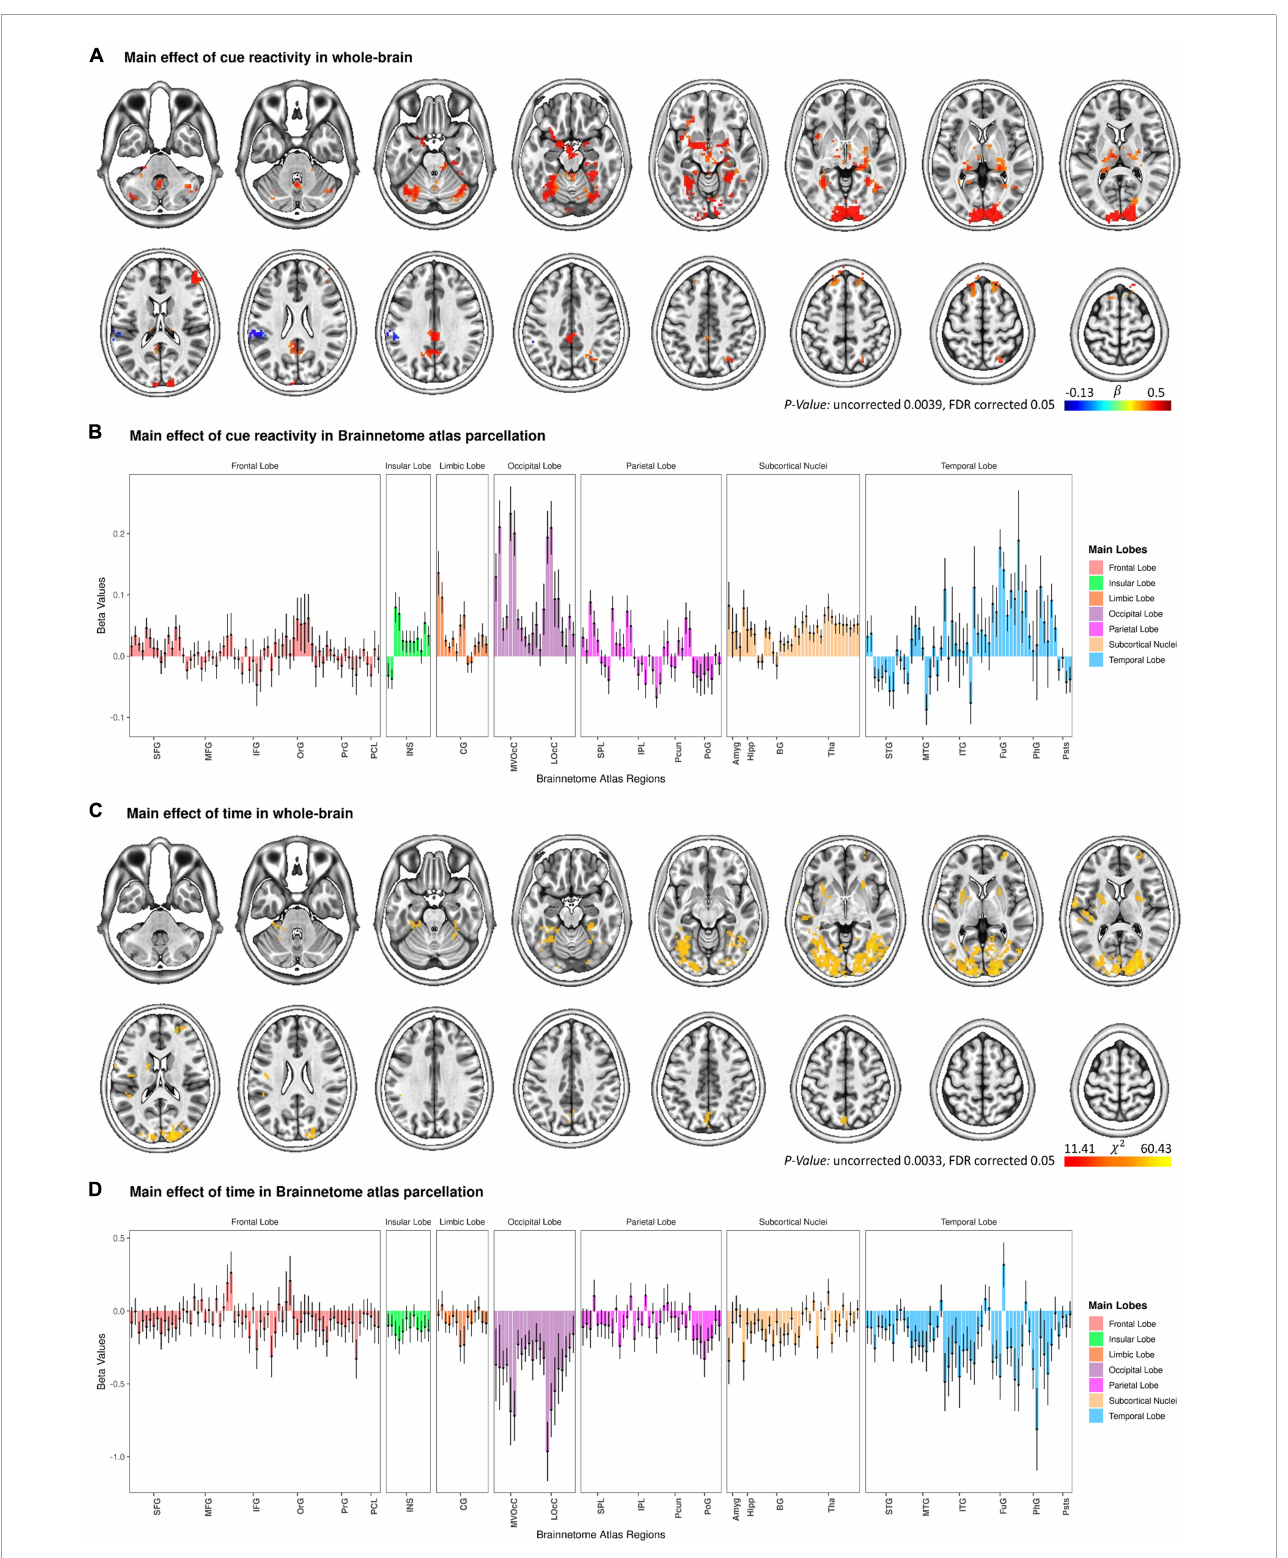
FIGURE2 Change in functional brain activation during the functional magnetic resonance imaging (fMRI) food cue-reactivity task. Main effect of cue reactivity on the whole brain functional activation (A) and on Brainnetome atlas regions (B) . Main effect of Time on the whole brain functional activation (C) and on Brainnetome atlas regions (D) . Data in bar charts are represented as mean ± s.e.m. Tha, thalamus; BG, basal ganglia; Hipp, hippocampus; Amyg, amygdala; LOcC, lateral occipital cortex; MVOcC, medioventral occipital cortex; CG, cingulate gyrus; INS, insular gyrus; PoG, postcentral gyrus; Pcun, precuneus; IPL, inferior parietal lobule; SPL, superior parietal lobule; pSTS, posterior superior temporal sulcus; PhG, parahippocampal gyrus; FuG, fusiform gyrus; ITG, inferior temporal gyrus; MTG, middle temporal gyrus; STG, superior temporal gyrus; PCL, paracentral lobule; PrG, precentral gyrus; OrG, orbital gyrus; IFG, inferior frontal gyrus; MFG, middle frontal gyrus; SFG, superior frontal